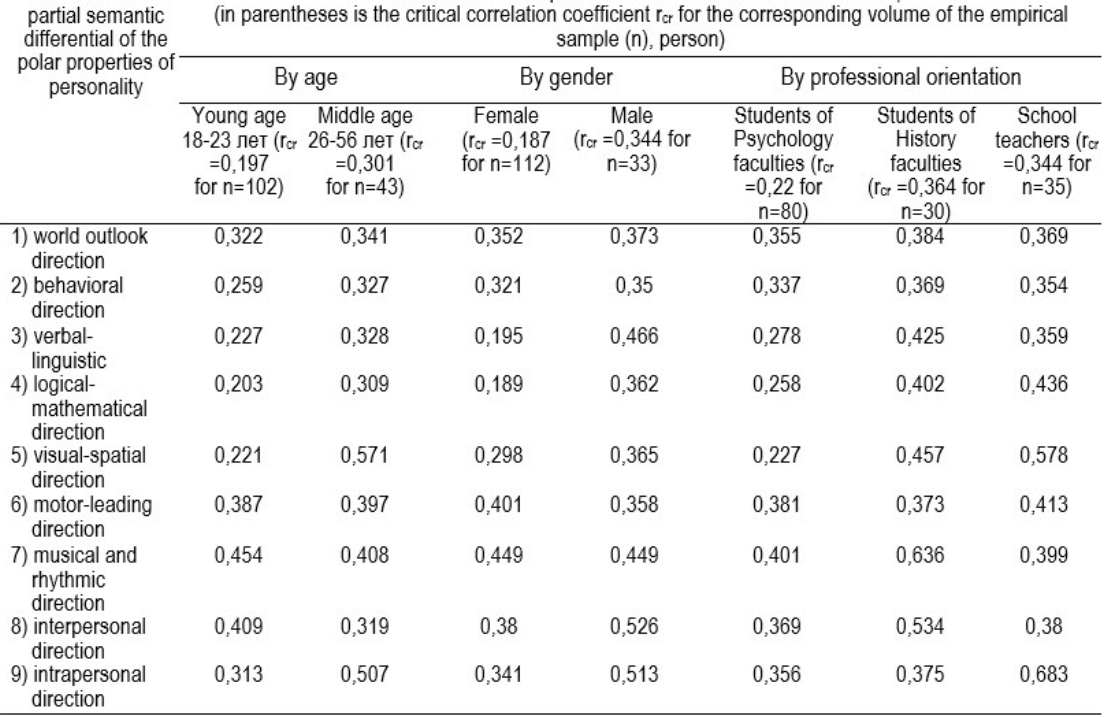
The empirical value of the Pearson correlation coefficients is r p≤.05) between the average values of the scales of the partial semantic differential of the personality’s polar properties and the meaningfulness of life test by D. A.